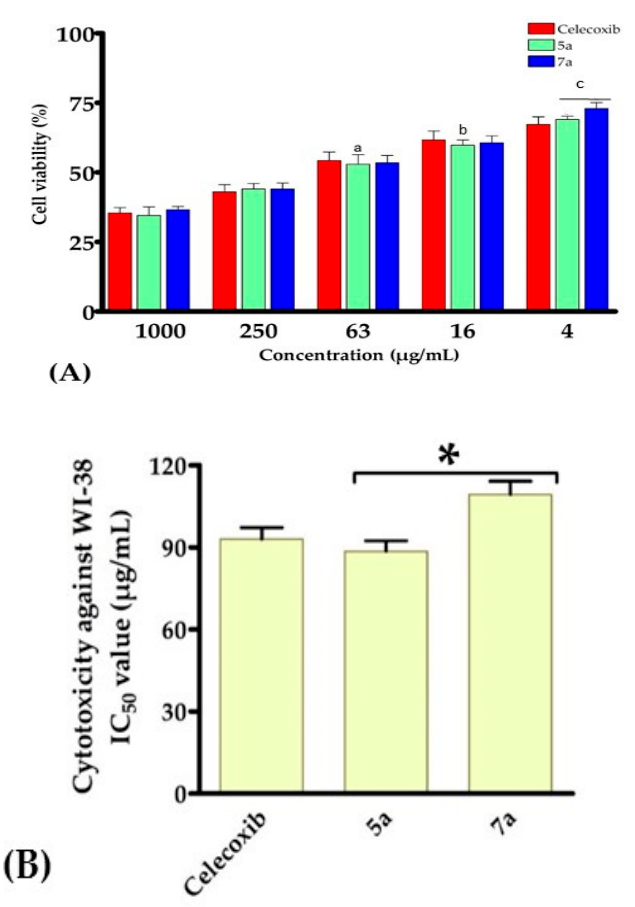
Figure 5. In vitro cytotoxicity of compounds 5a and 7a against WI-38 cell line (n = 4). ( A ) Percentage of cell viability in different concentrations. ( B ) IC 50 values ( µ g/mL). Data are presented as mean ± SD. a p < 0.05 versus celecoxib at concentration (63 µ g/mL), b p < 0.05 versus celecoxib at concentration (16 µ g/mL), c p < 0.05 versus celecoxib at concentration (4 µ g/mL) * p < 0.05 versus celecoxib for the IC 50 value.